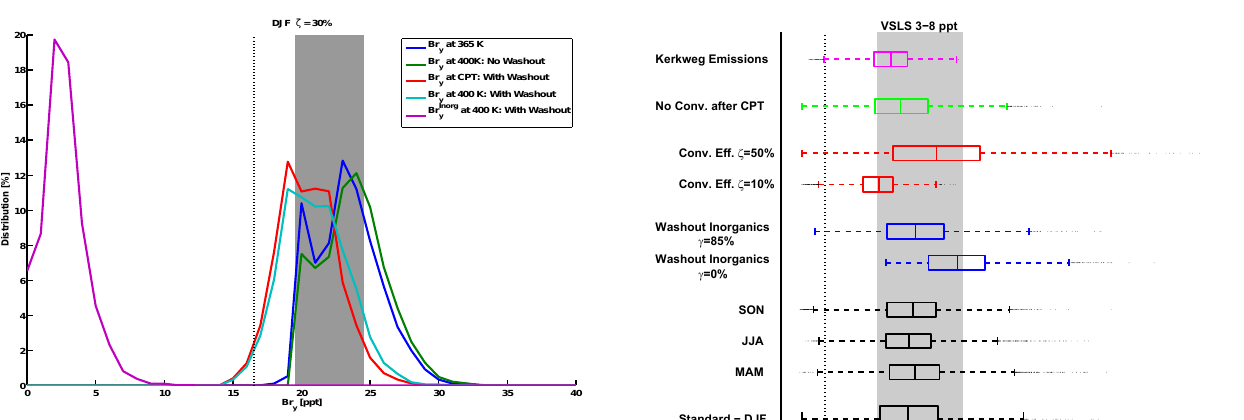
Fig. 8. The breakdown of the Br y distribution over all trajecto- ries (% of total trajectories). Br y at 2 = 365K (blue), at 2 = 400K for complete washout ( γ = 1) (teal), at 2 = 400K with no washout ( γ = 0) (green), and at the CPT directly after complete washout γ = 1 (red) (this is the same as the distribution at 2 = 400K when no convection above the CPT is assumed). The total Br Inorg y at 400K is also provided (magenta). The dashed line provides the Halons+CH 3 Br contribution (16.5ppt for 2000), and the grey shaded region the WMO recommendation for an additional 3–8ppt from VSLS (WMO, 2006, Table 2–8).